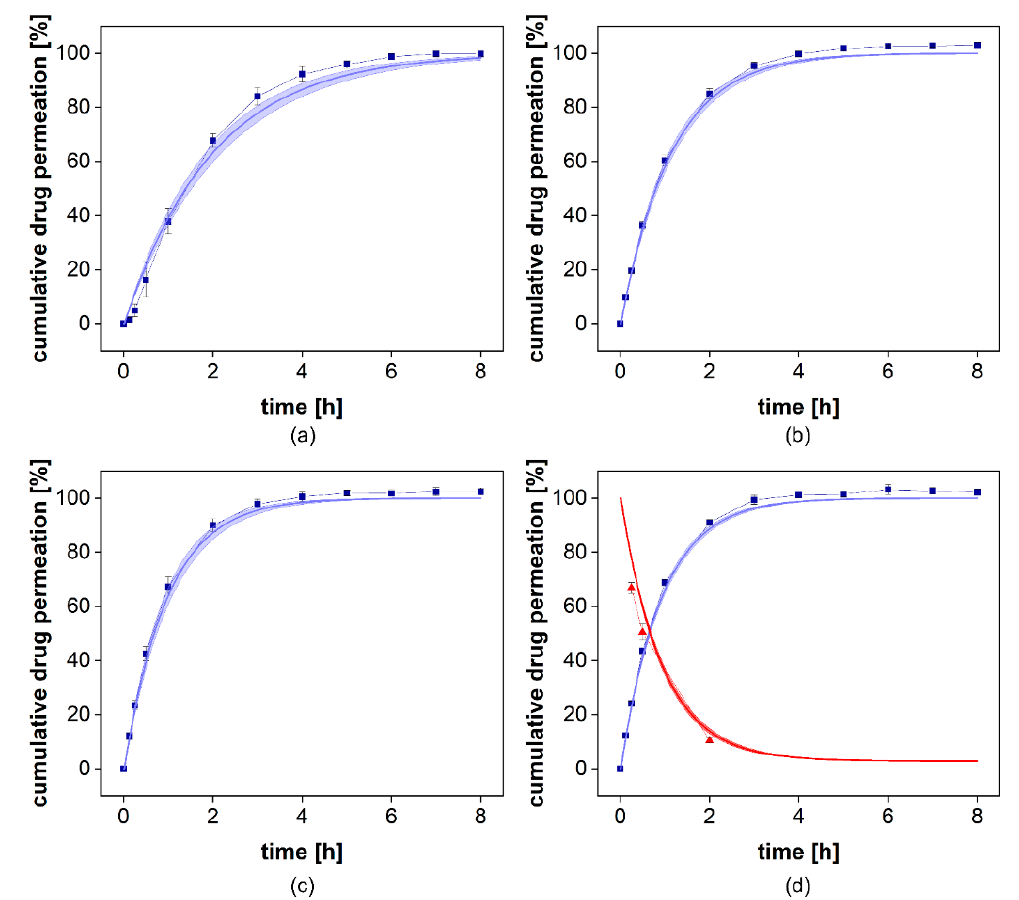
Figure 10. Comparison of observed and simulated permeation profiles at 0 ( a ), 25 ( b ), 50 ( c ), and 100 rpm ( d ). The blue squares indicate the mean ± SD ( n = 6) observed cumulative drug permeation and the blue line presents the simulated cumulative drug permeation using the mean k m ± SD. In ( d ) the donor compartment was evaluated. The red triangles indicate the observed mean ± SD ( n = 6) with the corresponding simulated relative donor concentration as the red line.